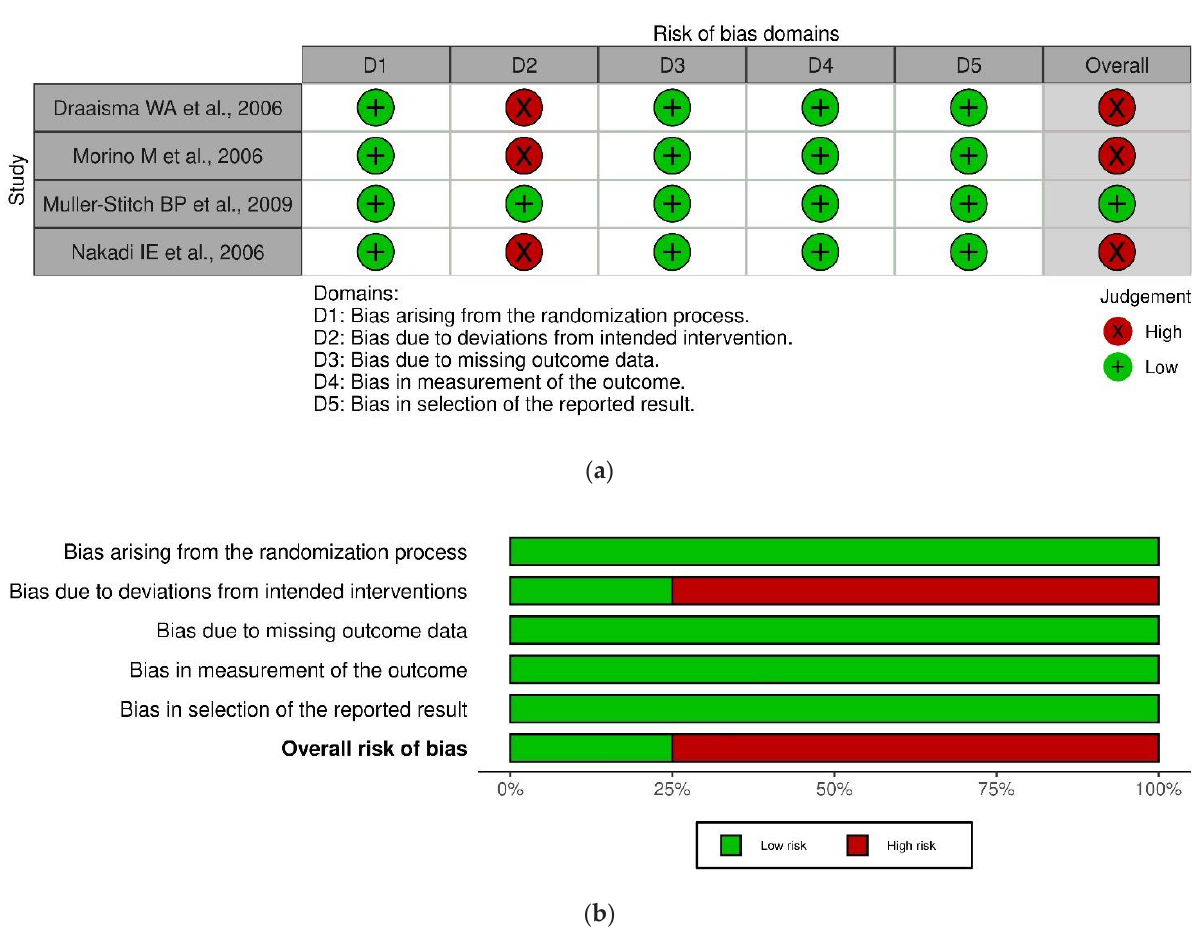
Figure 2. Summary of risk of bias for RCT studies [27,32 – 34].